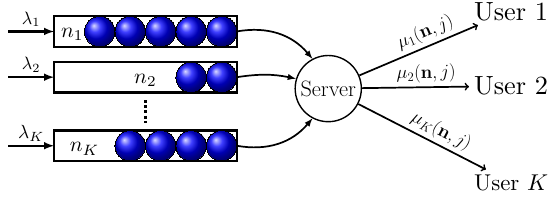
Figure 1: Queueing model for an access point